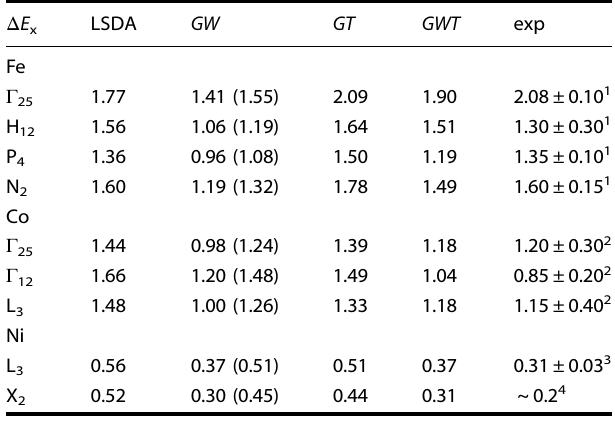
GW values in brackets are calculated without the Δ x correction in the reference system (see